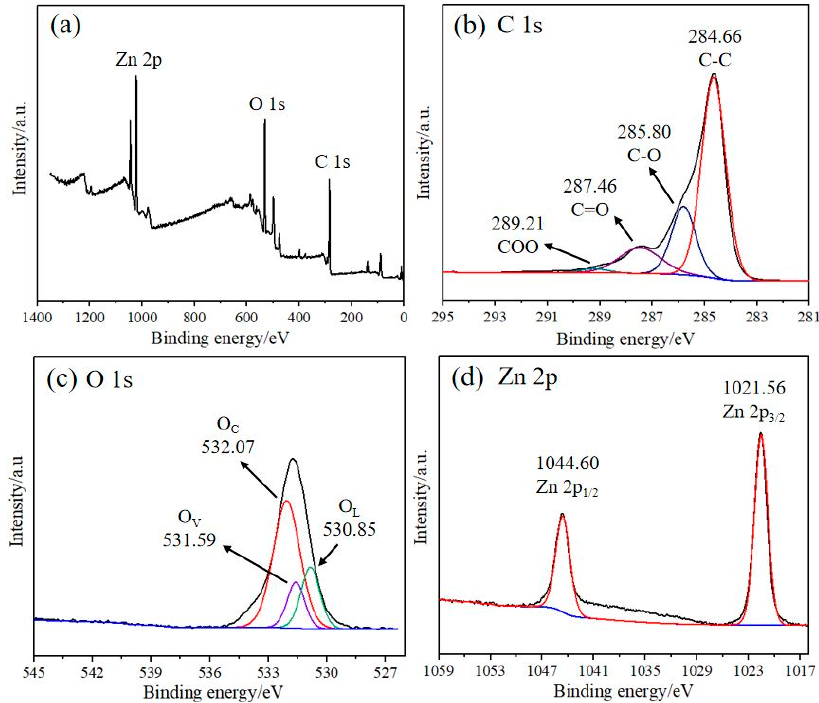
Figure 5. XPS spectra of ( a ) the rGO/ZnO-5 nylon fiber, ( b ) C 1s, ( c ) O 1s, and ( d ) Zn 2p.